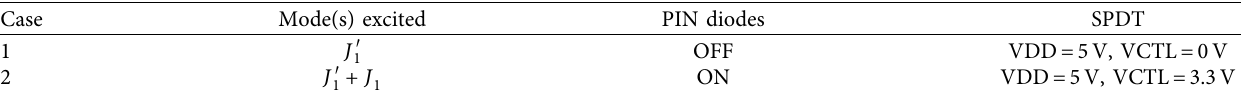
Figure 12: Final antenna prototype: (a) top view; (b) bottom view; (c) antenna with bias platform; (d) antenna in anechoic chamber. Table 2: Reconfigurable antenna configuration: case 1 (bidirectional pattern) and case 2 (unidirectional pattern).